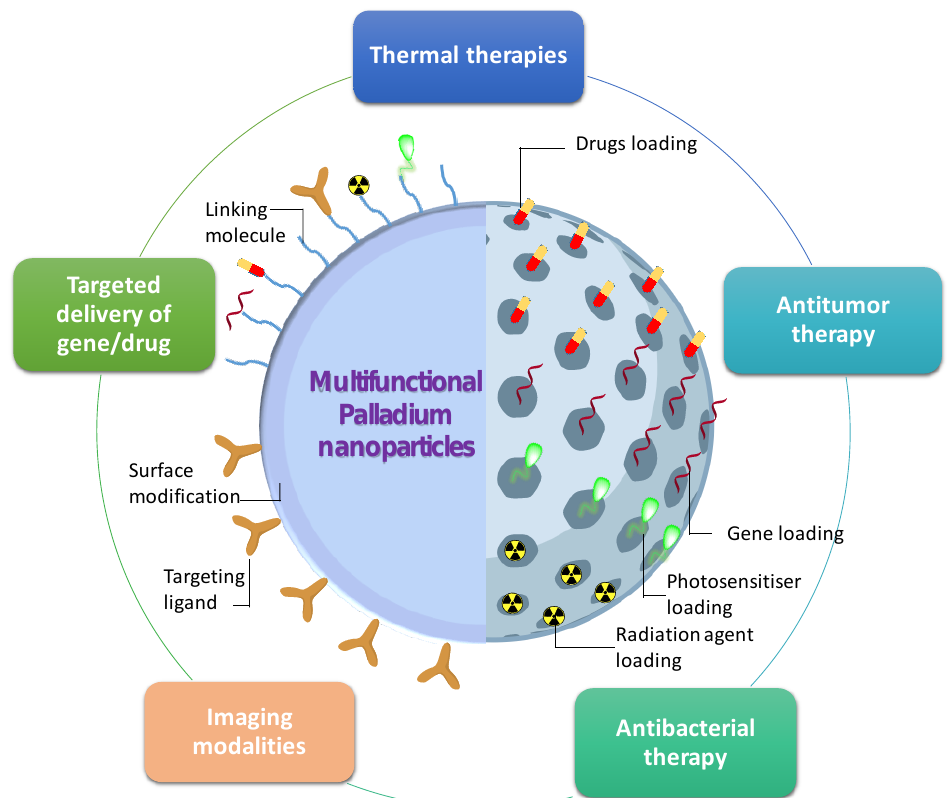
Figure 3. Illustration of the multifunctional PdNPs for multi-applications.